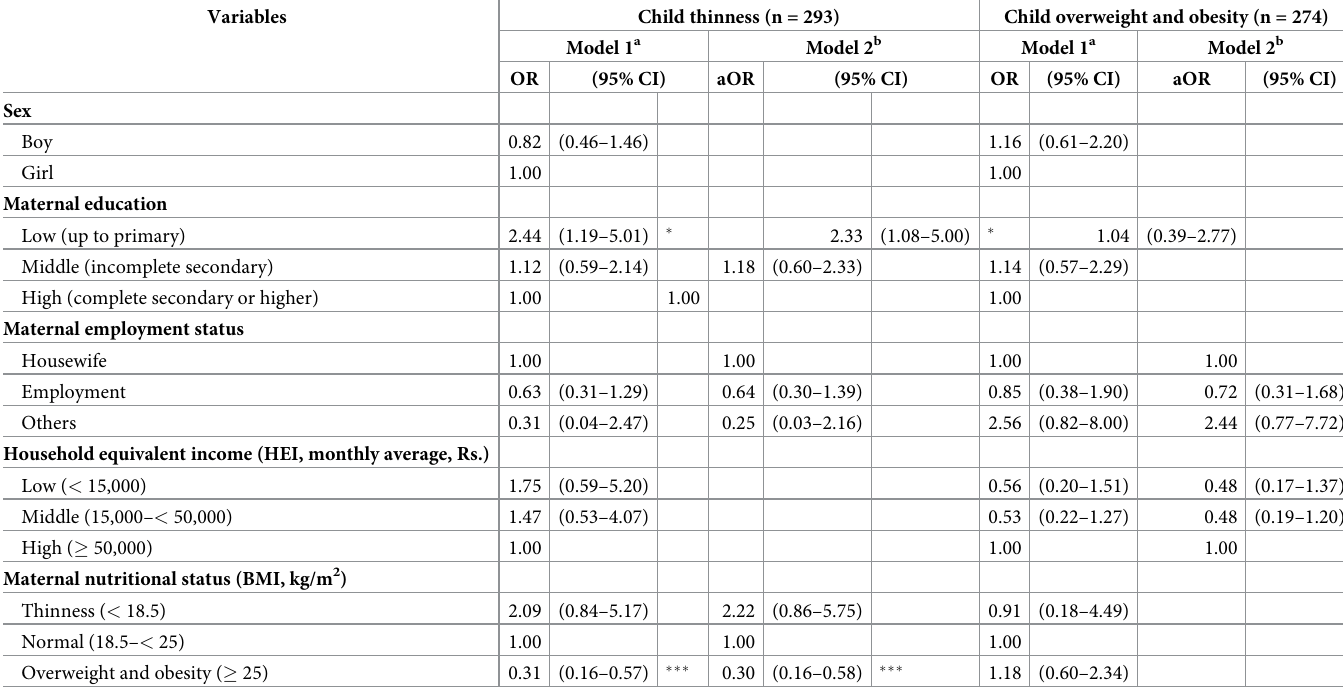
Table 4. Adjusted odds ratios (aOR) for child nutritional status in urban Sri Lanka, using crude analysis and multiple regression models (n = 339).